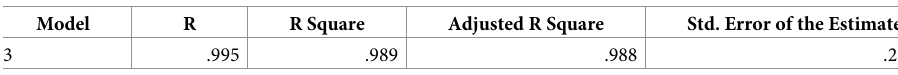
Table 10. Model summary.